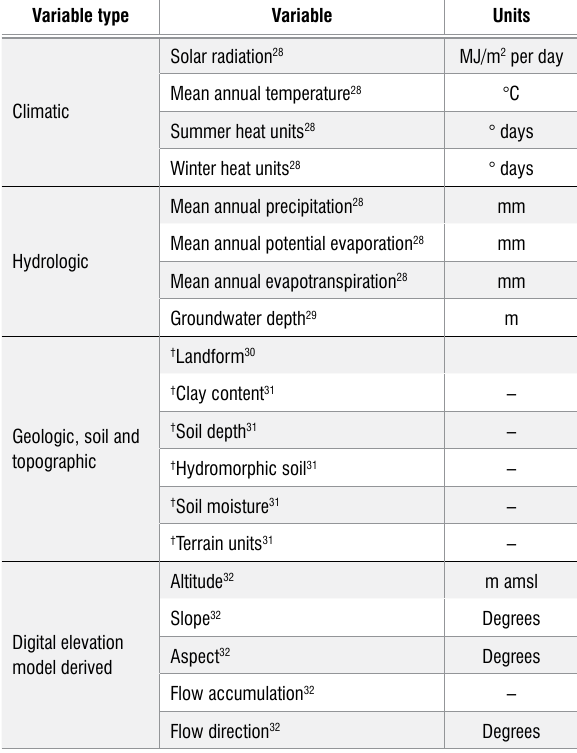
Table 1: Maximal list of input variables used to develop predictive wetland